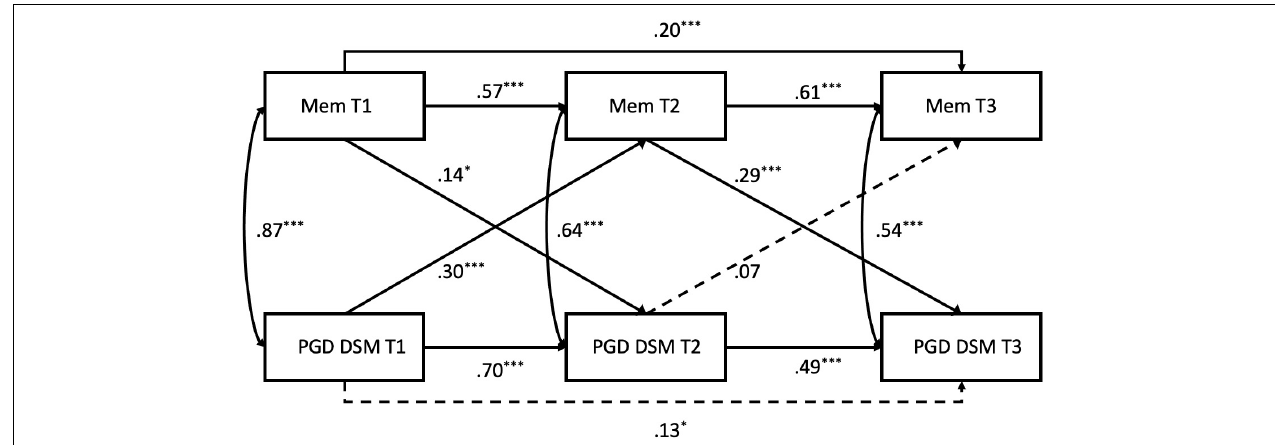
FIGURE 2 | Autoregressive cross-lagged model of PGD DSM5-TR and loss-related memory characteristics. Standardised coefficients are shown. Broken lines indicate non-significant paths. MEM, The Oxford Grief Memory Characteristics Scale (OG-M); PGD DSM, Prolonged Grief Disorder according to the DSM-5-TR diagnostic criteria. Asterisks indicate significant associations ( ∗∗ p < 0.01, ∗∗∗ p < 0.001). χ 2 = 5.12, df = 2, p > 0.05, RMSEA = 0.075, CFI = 1.00 TLI =